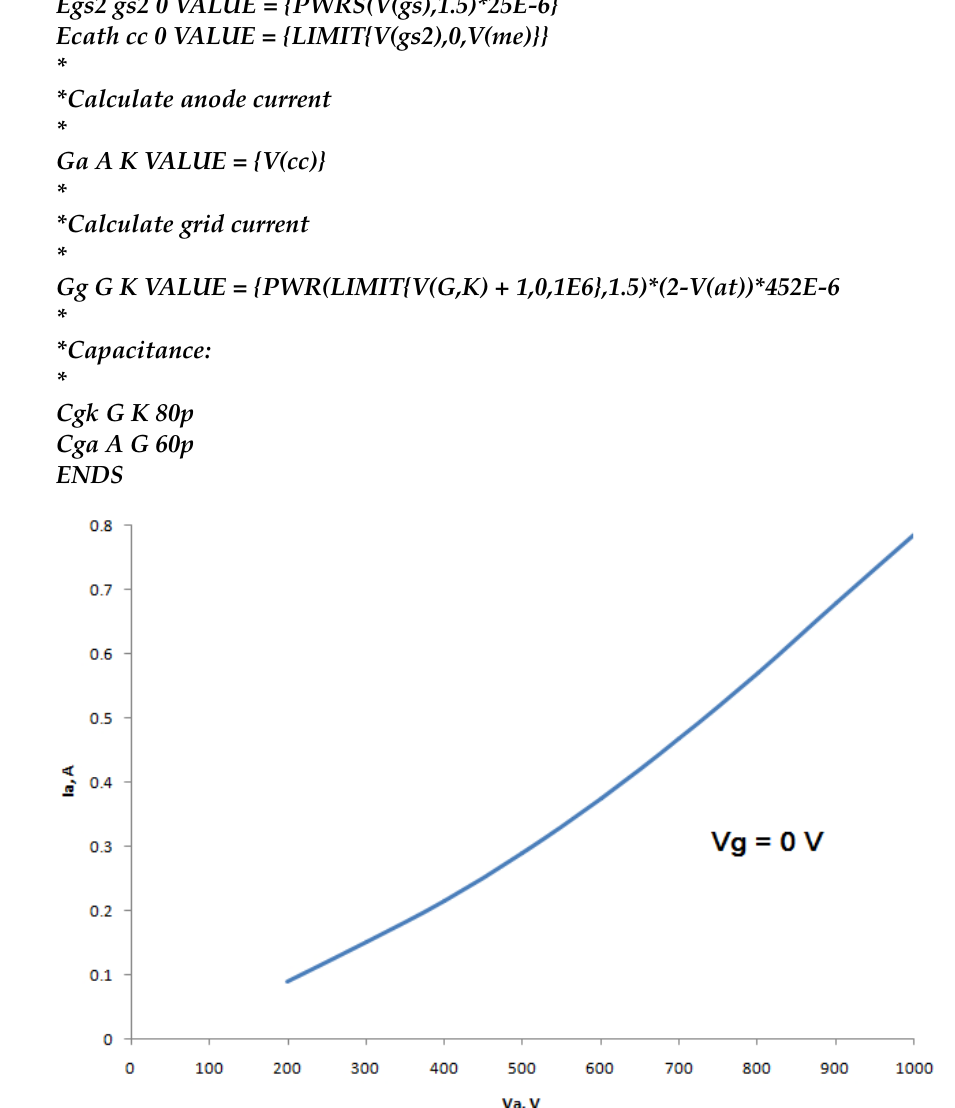
Table 3. The various components of the model and their